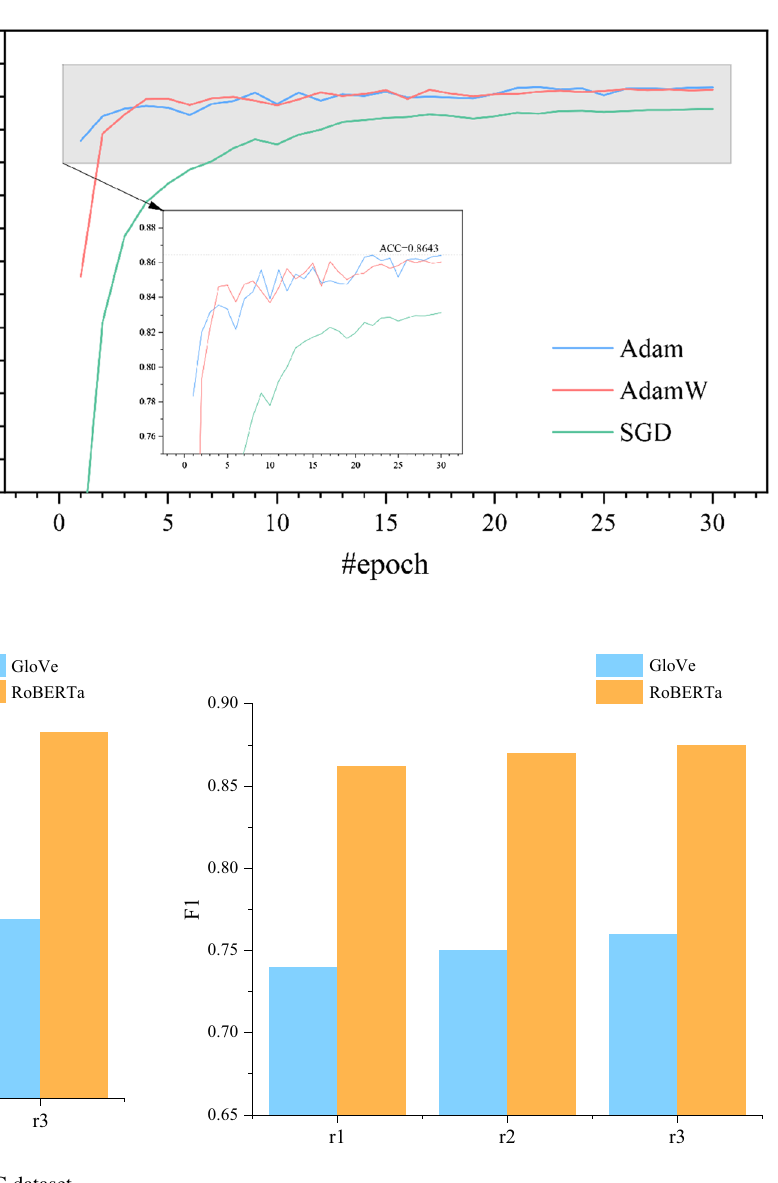
Fig. 13 F1 score of ablation experiments on the 20NG dataset Table 3 Labels of the 20NG subset